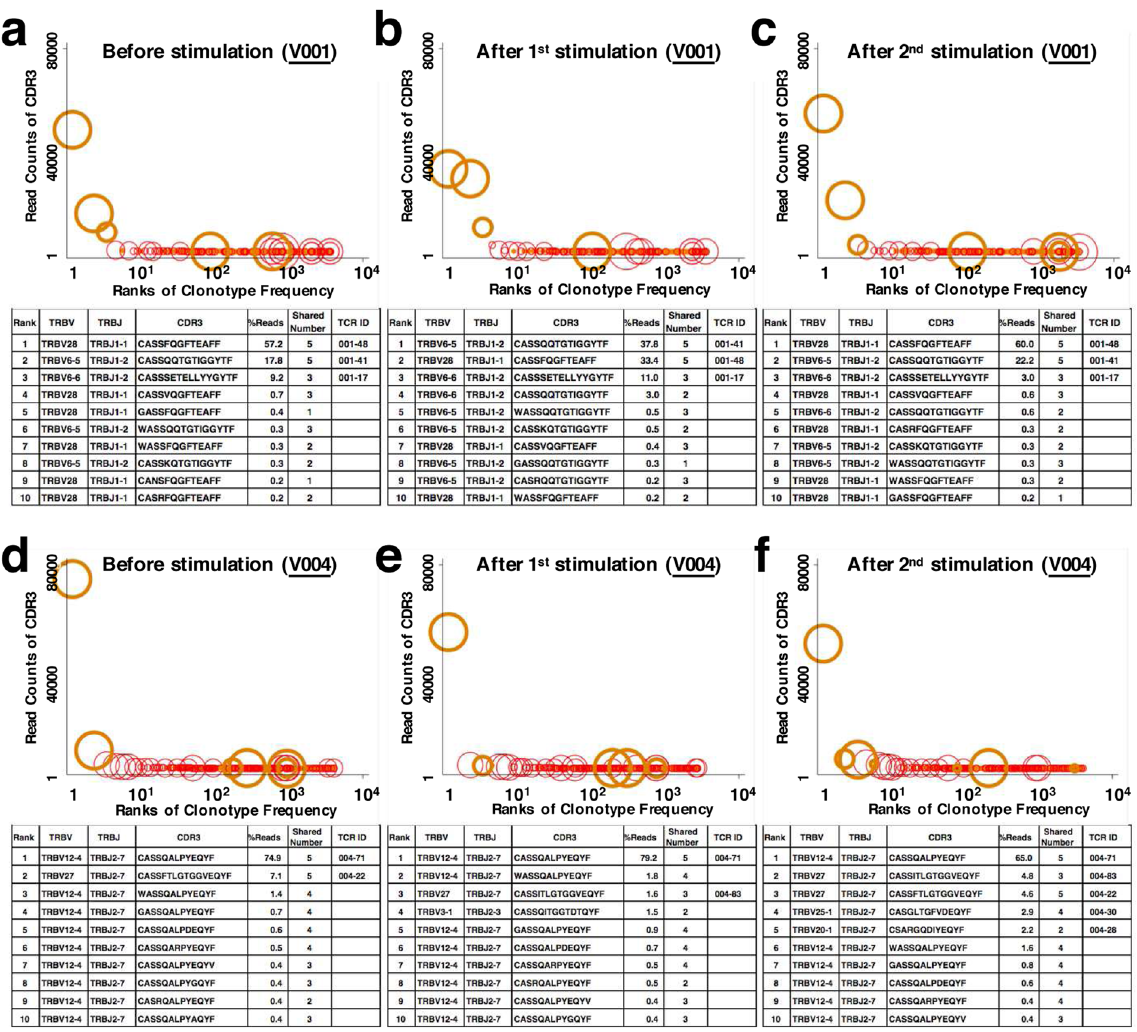
Figure 5. Distributions of read numbers of CMV-NLV-specific TCR β clonotypes. Cells from the HLA-A2- positive and CMV-seropositive donors V001 and V004 that were detected using the HLA-A2-NLV tetramer probe were sorted and isolated from unstimulated PBMCs ( a , d ) and PBMCs stimulated once ( b,e ) or twice ( c,f ) with the NLV peptide. The sorted cells were then subjected to NGS. Each marker in the plots shows one unique read of CMV NLV-specific TCR β . The TCR β clonotypes are ordered according to their frequencies on the x-axis. The y-axis depicts the read number of the clonotypes. Shared CMV NLV-specific TCRs and unshared CMV NLV-specific TCRs are shown as red circles and red dots, respectively. Orange thick circle represents one of nine dominant TCRs in V001 (TCR ID; 001-17, 001-48, 001-41) and V004 (TCR ID; 004-66, 004-22, 004- 63, 004-30, 004-28 and 004-71) (Fig. 2a). The sizes of the circles represent the number of sharing (two to five) among the five donors. The largest circle indicates that the corresponding TCR clonotype were shared by the five donors. The Wilcoxon rank-sum test was performed to assess whether public CMV NLV TCRs occupy a higher rank of the read numbers compared with the private CMV NLV TCRs. Wilcoxon rank-sum test and Kendall’s tau test were performed. All tests were statistically significant (P < 0.05). The ranks (the first to tenth) of %read of CMV NLV-specific TCR β clonotypes are shown in the tables below the